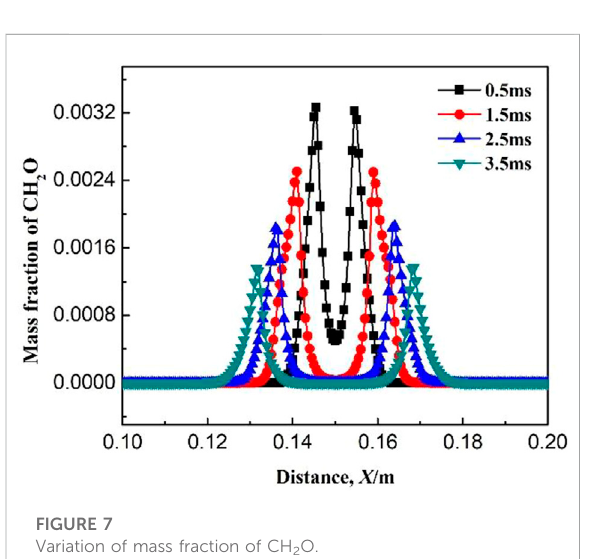
FIGURE 6 Variation of mass fraction of CH 3 .